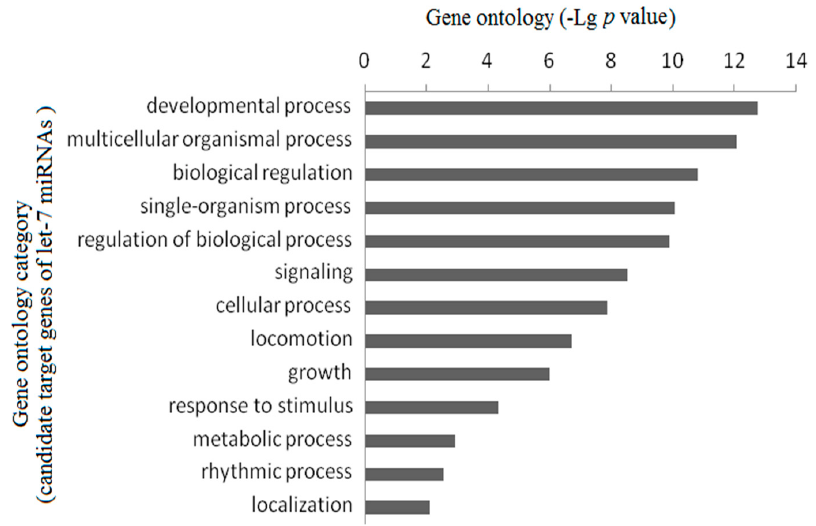
Figure 4. Gene ontology analysis of putative target genes of let-7 miRNAs.